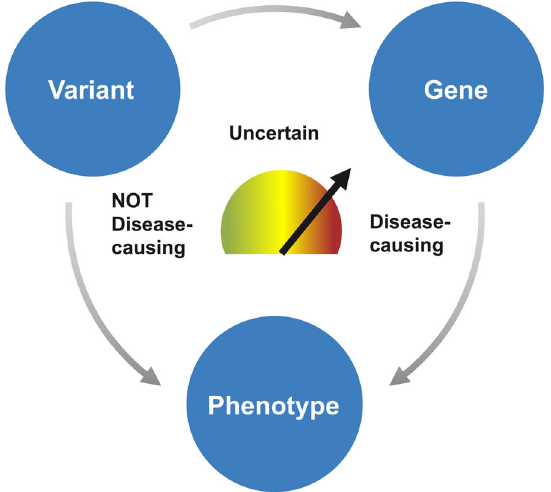
Fig. 3 Triage review decision-making process. Variant, gene, and phenotype information must be simultaneously integrated to determine which variants should be nominated as potentially